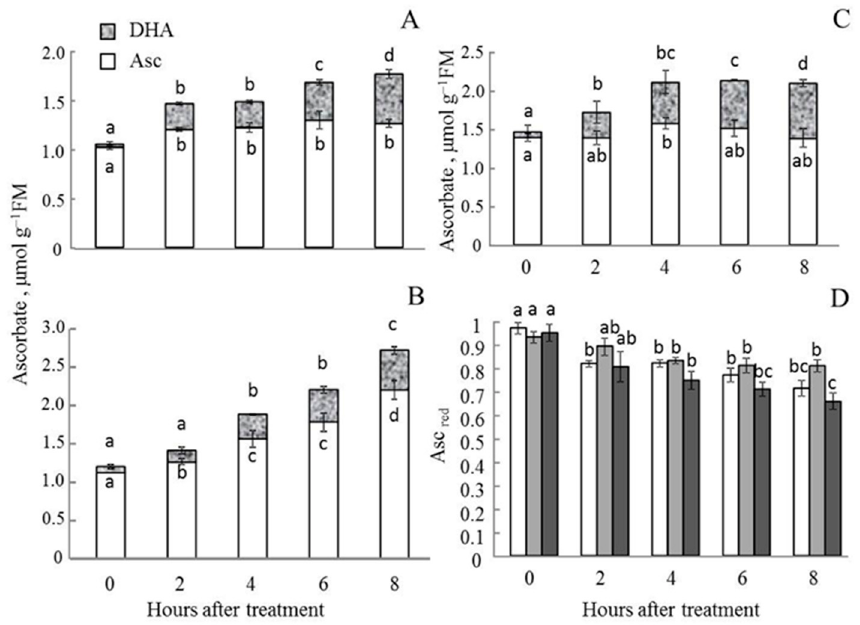
Figure 7. Changes in total cellular reduced and oxidized ascorbate (Asc and DHA, respectively) pools in leaves of WT ( A ), XX-2 ( B ), and AS-12 ( C ) Arabidopsis thaliana plants grown at 90 µ mol m − 2 s − 1 (0 h) and after 2–8 h of moderately high light (400 µ mol m − 2 s − 1 ). ( D ) The relative ascorbate content (Asc/(Asc + DHA), Asc red ). Data are presented as mean ± SE of values from three independent experiments (n = 6–10 from each experiment). Significant differences between mean values (ANOVA, Duncan’s test, p < 0.05) are indicated by different letters (a, b, c, d) The same or double letters (ab, bc) indicate no significant differences between the means.